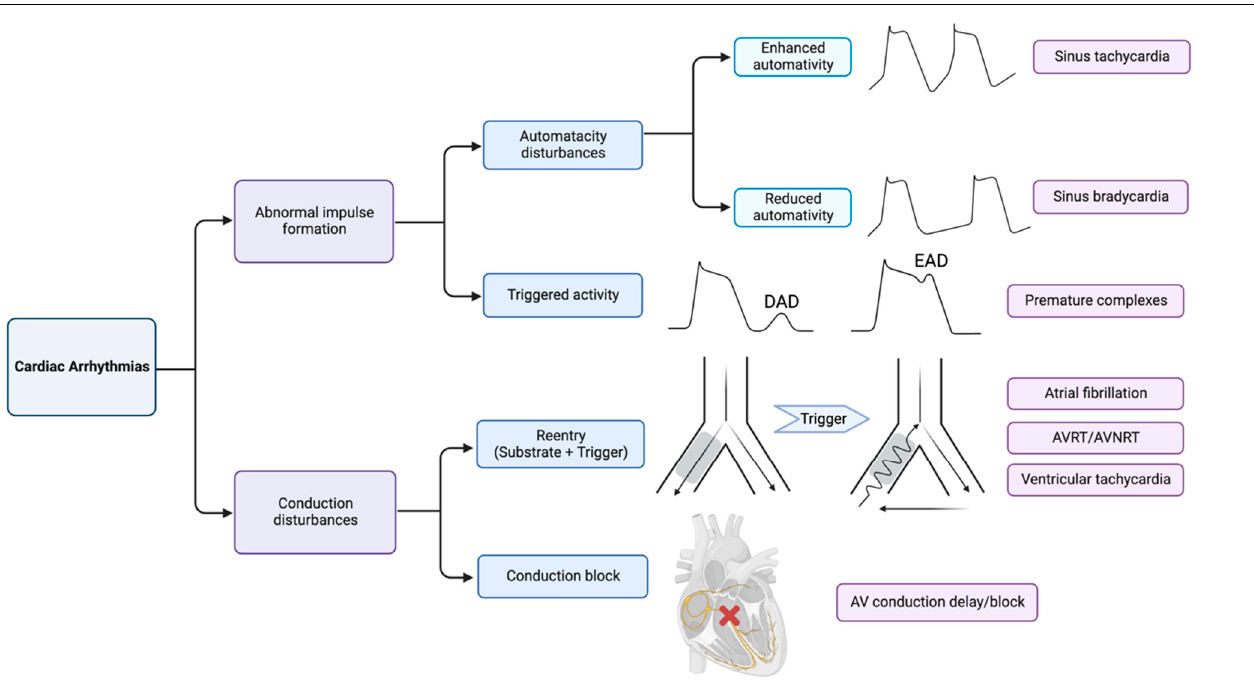
Figure 1. Summary of molecular mechanisms of arrhythmias. Cardiac arrhythmias can be divided to abnormal impulse formation (also termed as focal activity) and conduction disturbances. Automaticity problems involve both enhanced and reduced automaticity, which are the etiology of sinus tachycardia and bradycardia, respectively. Early and late after depolarization is the common mechanism of both atrial and ventricular premature complexes. Reentrant tachyarrhythmias as a conduction disturbance usually involve both substrate (reduced conduction velocity) and trigger where an impulse circles back to re-excite the myocardium through retrograde conduction via the area of functional block. Conduction delay/block also belongs to conduction disturbances.